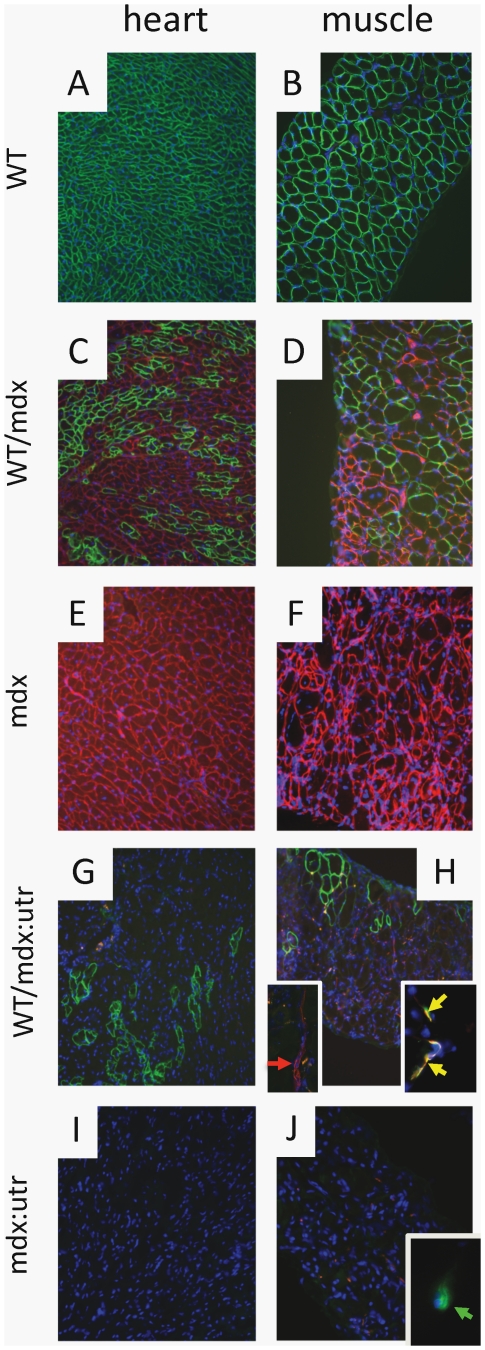
Dystrophin is supplied to chimeric muscle.WT (A, B), WT/mdx (C, D) and WT/mdx∶utrophin (G, H) heart and diaphragm muscle display sarcolemma-dystrophin (green staining); WT/mdx (C, D) and mdx (E, F) heart and diaphragm muscle display sarcolemma-utrophin (red staining); red arrow: utrophin-positive axon (H inset left); yellow arrows: utrophin-positive (red)/alpha-BT-positive (green) NMJ (H inset right); green arrow: utrophin-negative/alpha-BT-positive (green) NMJ (J inset); blue: nuclear staining (DAPI). Magnification: 100×; H inset left and right: 200× and 400× respectively; J inset: 400×.